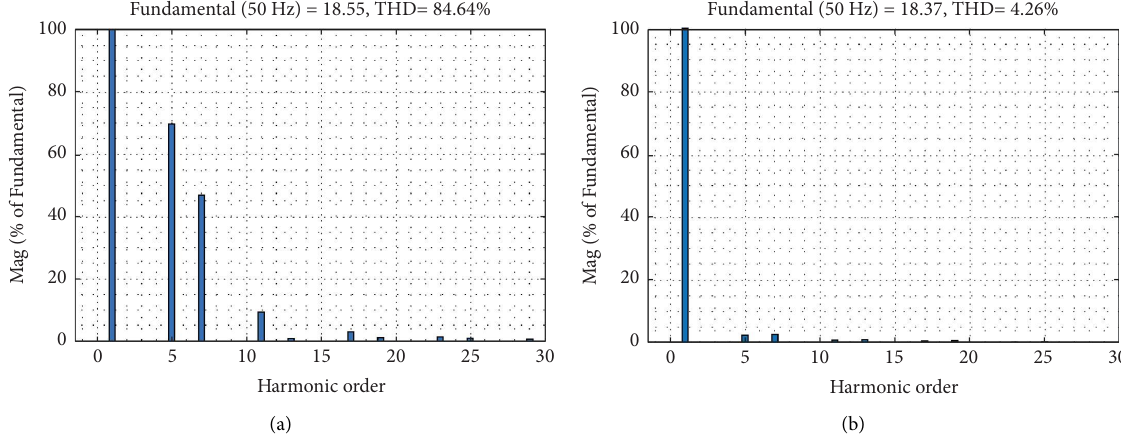
Figure 16: THD analysis of grid current using SC (a) before compensation and (b) after compensation, under RLC